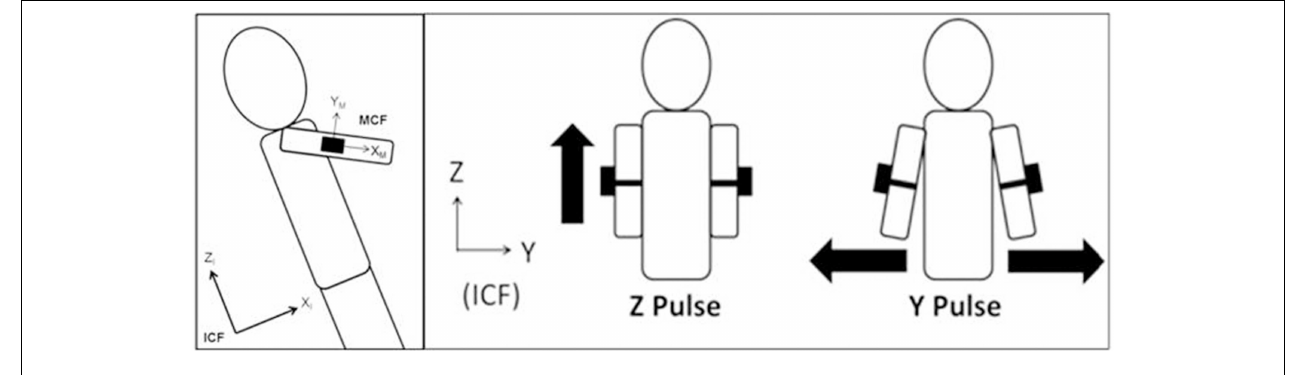
determine the orientation of the V2Suit module with respect to the ICF. The location of the module placement on the arms in this figure is for illustration purposes